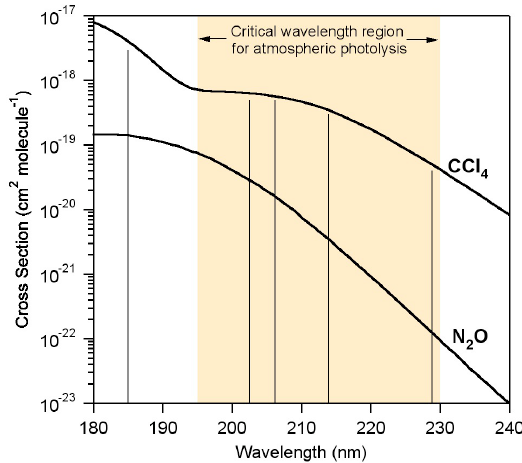
Fig. 1. The JPL06-2 (Sander et al., 2006) recommended UV absorp- tion cross section spectra of N 2 O and CCl 4 at 298K. The shaded area highlights the wavelength region most important for atmo- spheric photolysis. The vertical lines correspond to the wavelengths of the atomic lines used in this